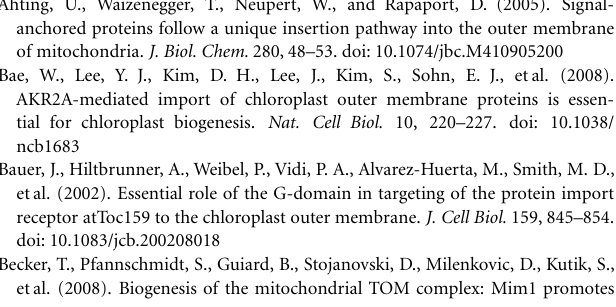
outer membrane. In the case of mitochondria, no cytosolic component for outer membrane-targeted TA proteins has yet been identified. However, the unique lipid composition of the outer membrane is important for the efficient insertion of TA proteins to the mitochondria. AKR2, ankyrin-repeat protein 2; ARSA1, arsenite transport 1; CTS, C-terminal sequence; TA, tail-anchored; TMD, transmembrane domain; +++ , positively charged amino acid residues; ?, postulated factor; dashed arrow, postulated